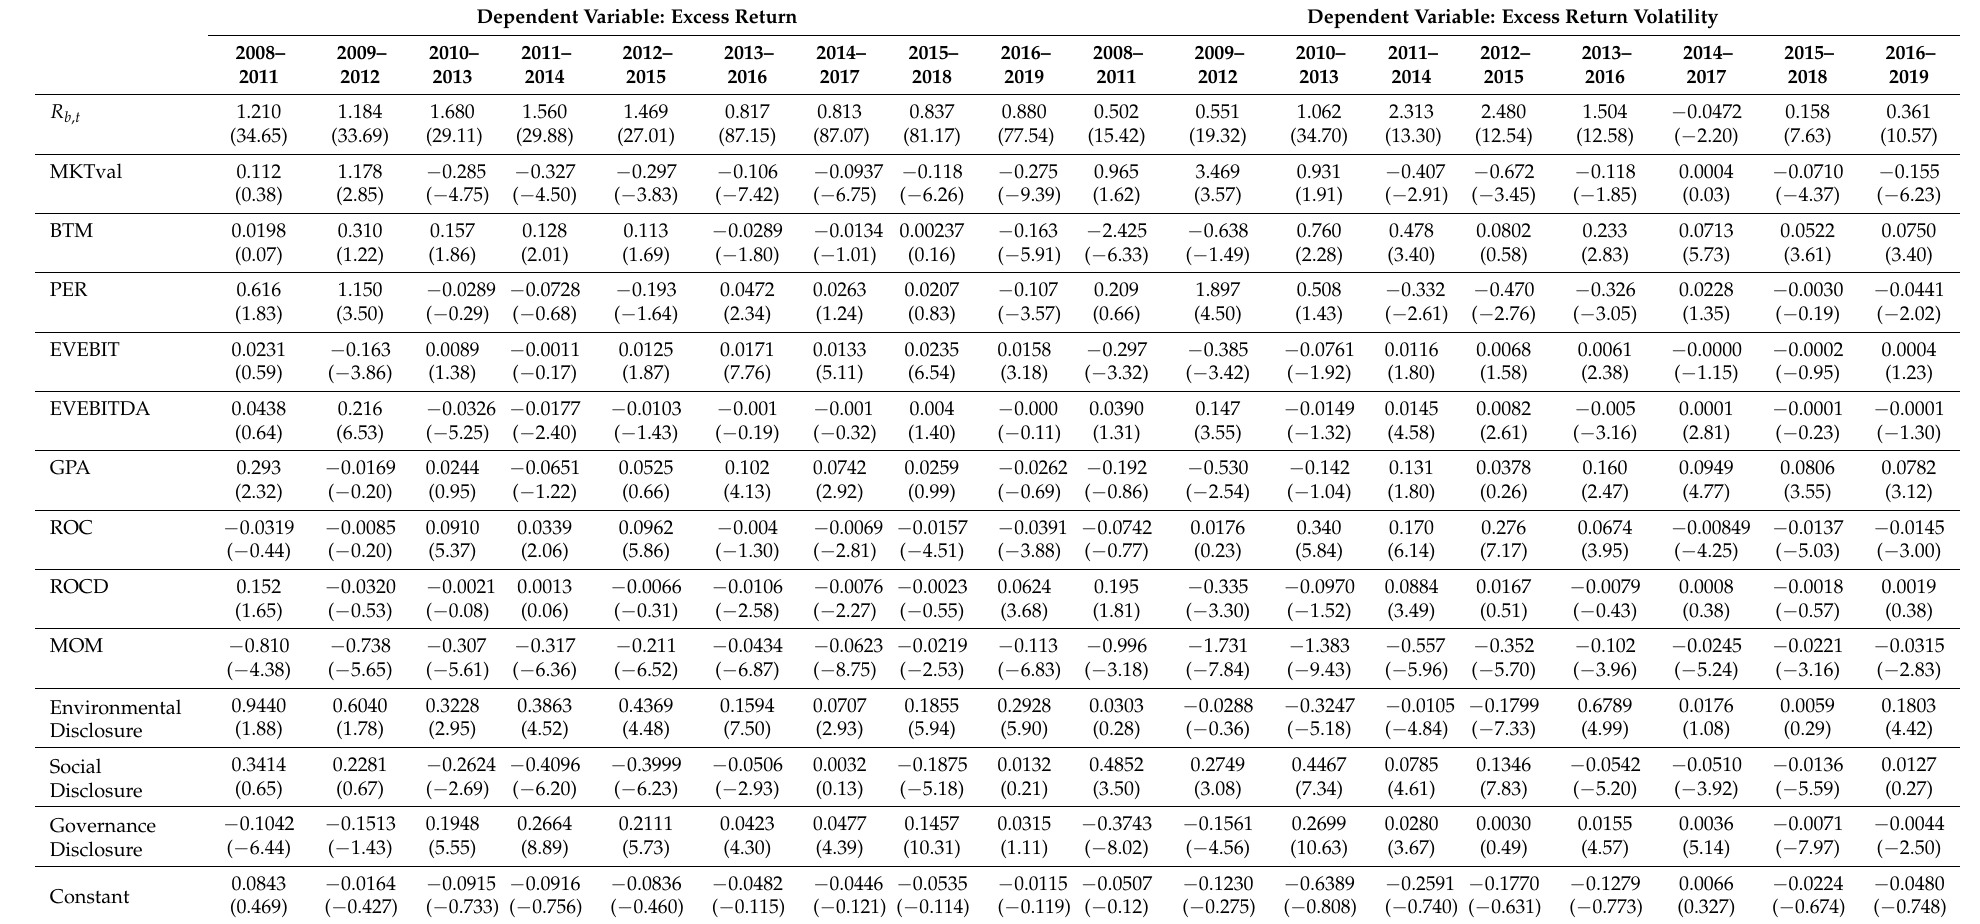
Table 6. Portfolio’s annualized excess return and volatilities of ESG disclosure over different time